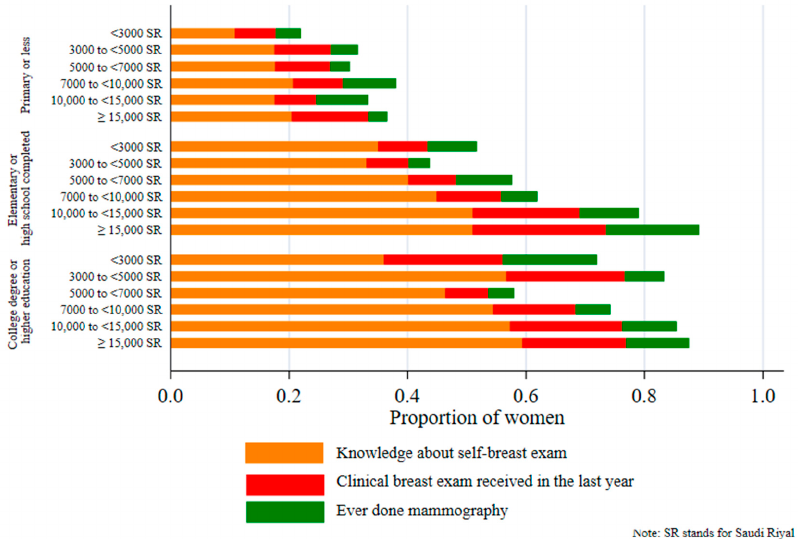
Figure 1. Distribution of breast cancer screening uptake by education and income.